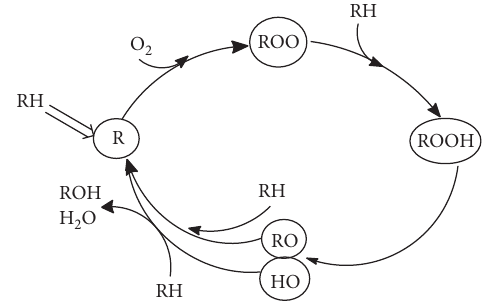
Figure 9: Oxidation process scheme for lubricating oils.